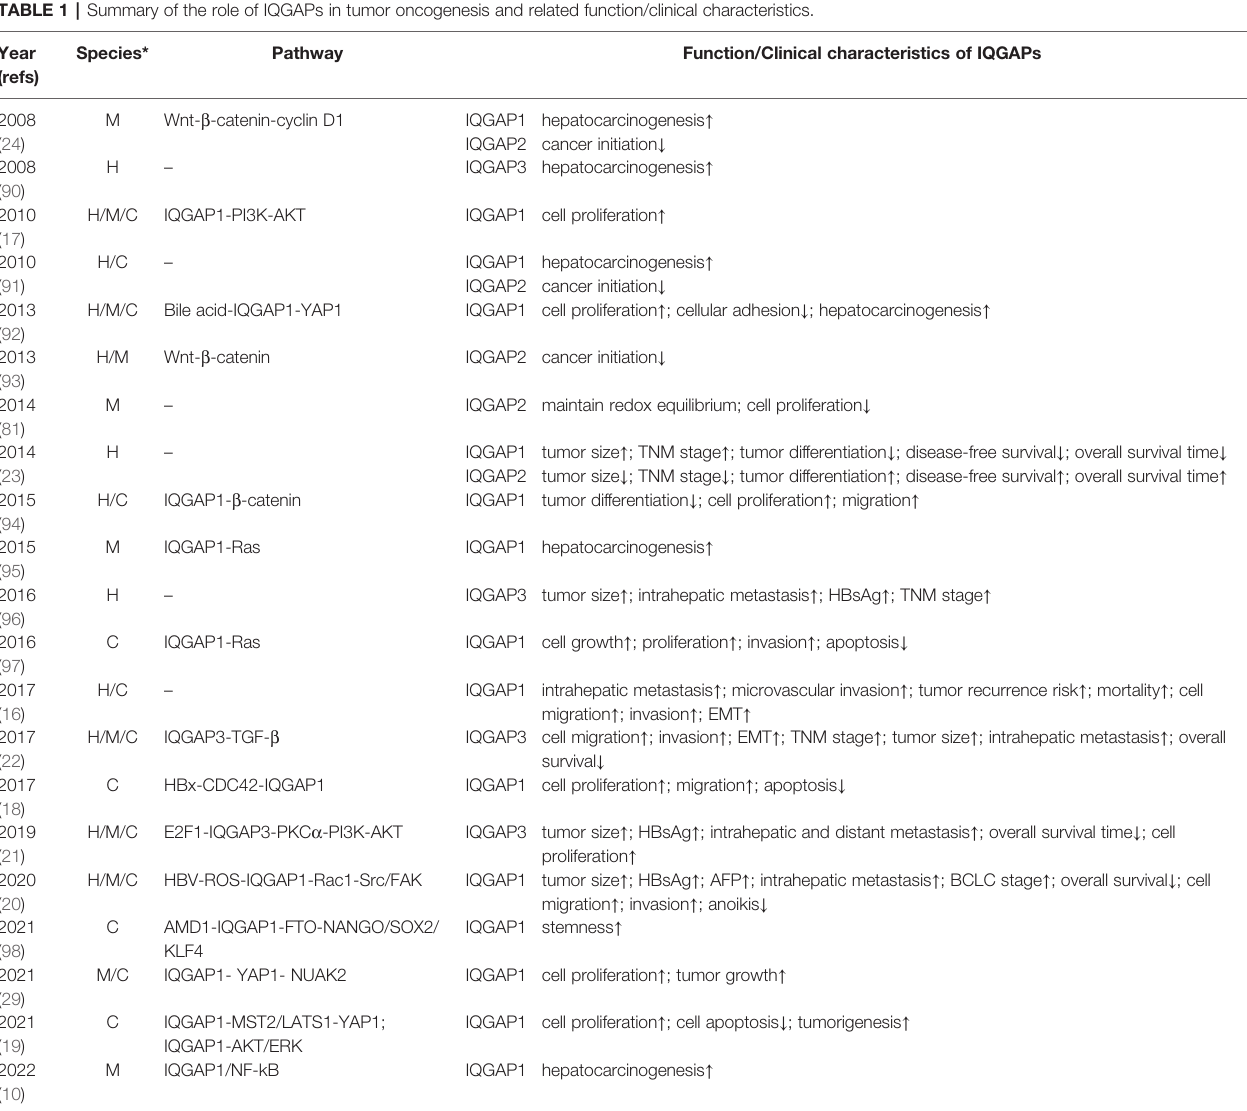
TABLE 1 | Summary of the role of IQGAPs in tumor oncogenesis and related function/clinical